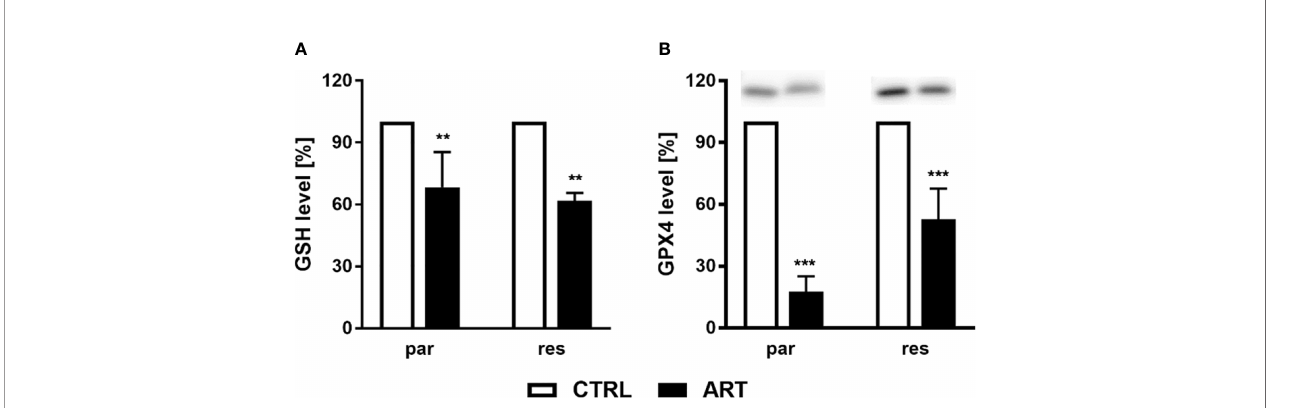
FIGURE 8 | ROS production: GSH level [%] of DU145 cells after 24 h incubation with ART [37.5 µM], compared to untreated controls (set to 100%) (A) . n = 3. Pixel density analysis of the GPX4 expression after exposure to ART [37.5 µM] (B) . Error bars indicate standard deviation (SD). Signi fi cant difference to untreated controls indicated by: **p ≤ .01, ***p ≤ .001. n = 3. For detailed information regarding the Western blots, see Figure